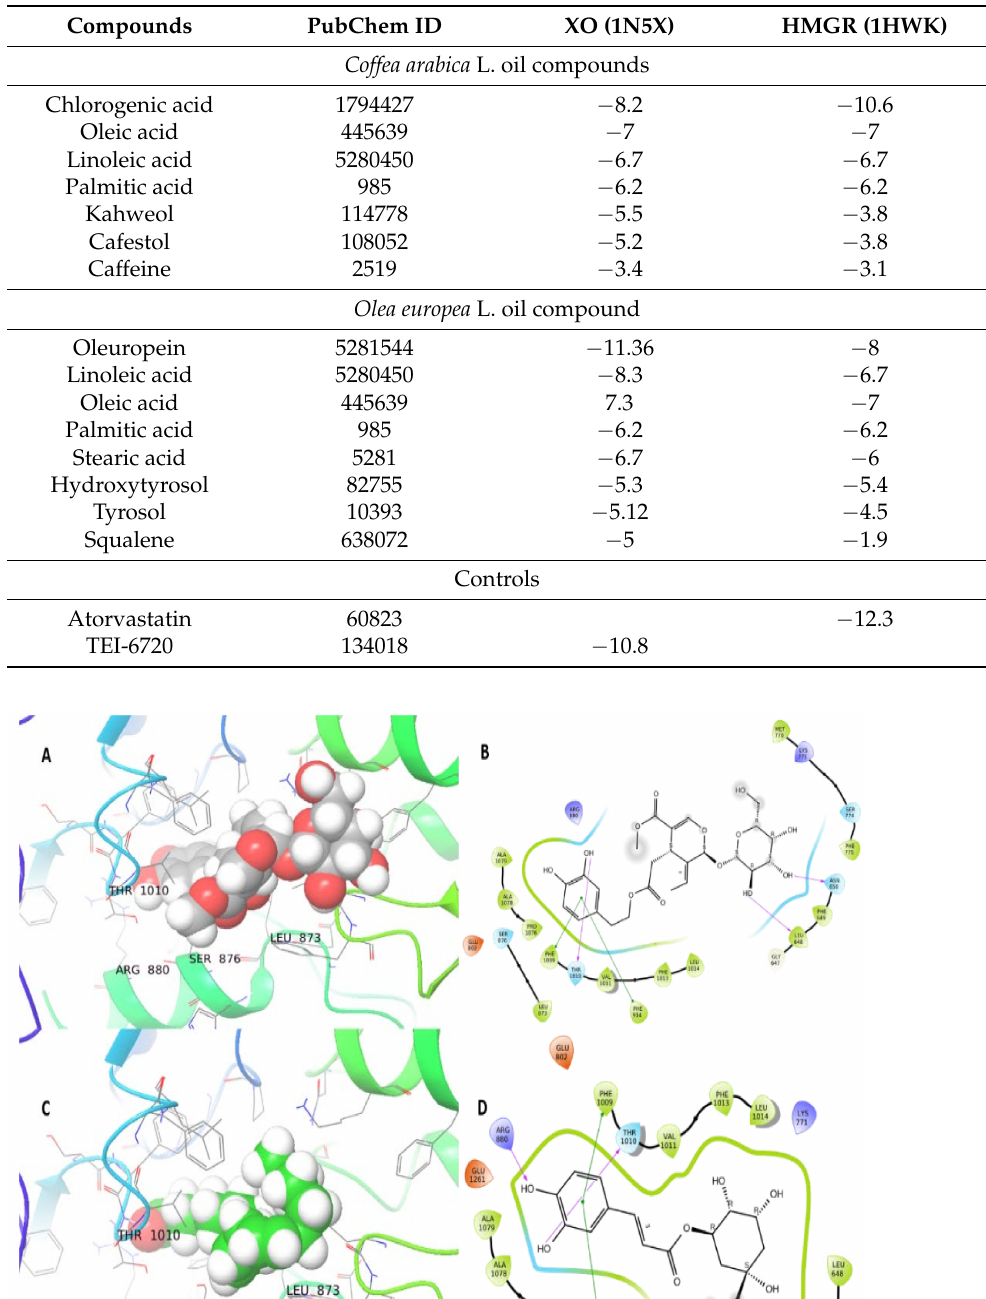
Table 1. The docking of Coffea arabica L. oil and Olea europaea L. oil compounds on XO and HMGR.